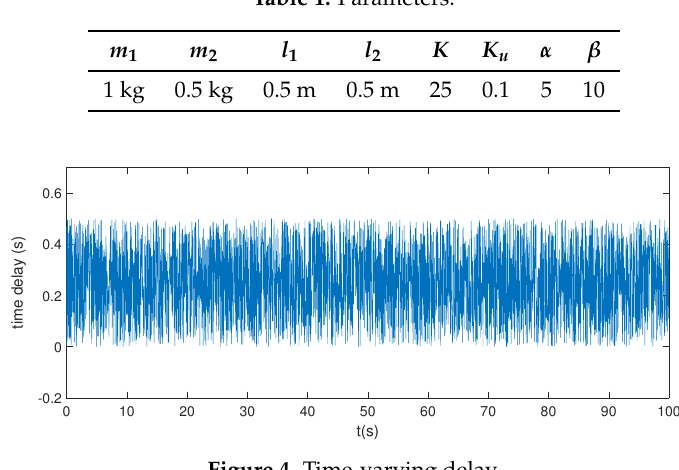
Figure 4. Time-varying delay.